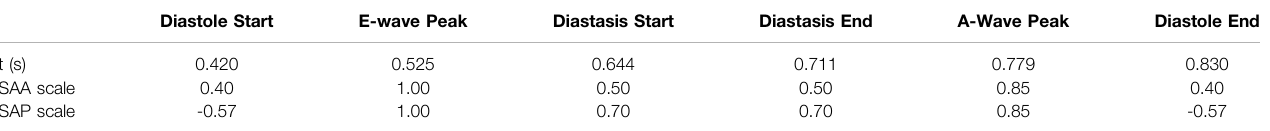
TABLE 1 | Timings of different parts of diastole, and scalings of the short axis anterior (SAA) and short axis posterior (SAP) of the MV model at those times. The timings are determined by analyzing changes in the rate of expansion of the LV. Note that the coaptation line does not coincide with the intercommissural line (long axes), but the scalings at diastole start and end correspond to both lea fl et edges coinciding with the coaptation line, i.e. the MV is closed at these